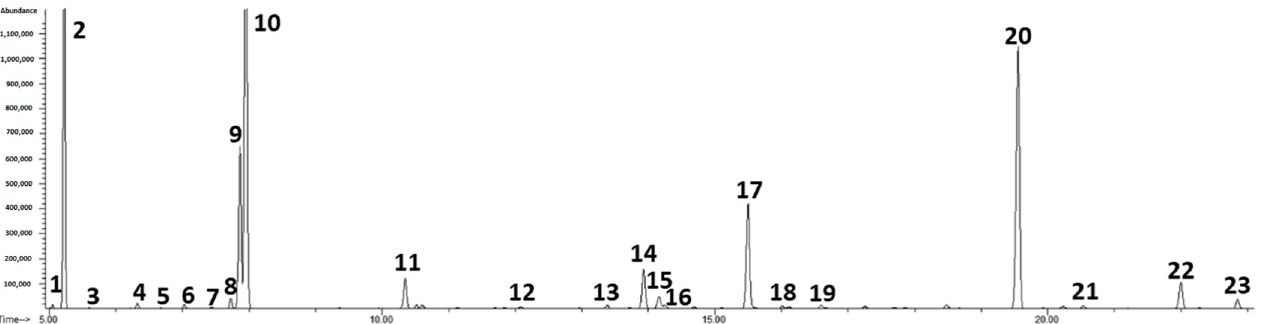
Figure 2. Chromatogram of volatile compounds of myrtle essential oil (1 = α -thujene; 2 = α -pinene; 3 = camphene; 4 = β -pinene; 5 = myrcene; 6 = α -phellandrene; 7 = 3-carene; 8 = p -cymene; 9 = d-limonene; 10 = eucalyptol; 11 = linalool; 12 = camphor; 13 = terpinen-4-ol; 14 = α -terpineol; 15 = myrtenol; 16 = estragole; 17 = nerol (is); 18 = carvone; 19 = geraniol; 20 = myrtenyl acetate; 21 = α -terpinyl acetate; 22 = geranyl acetate; 23 = methyleugenol).